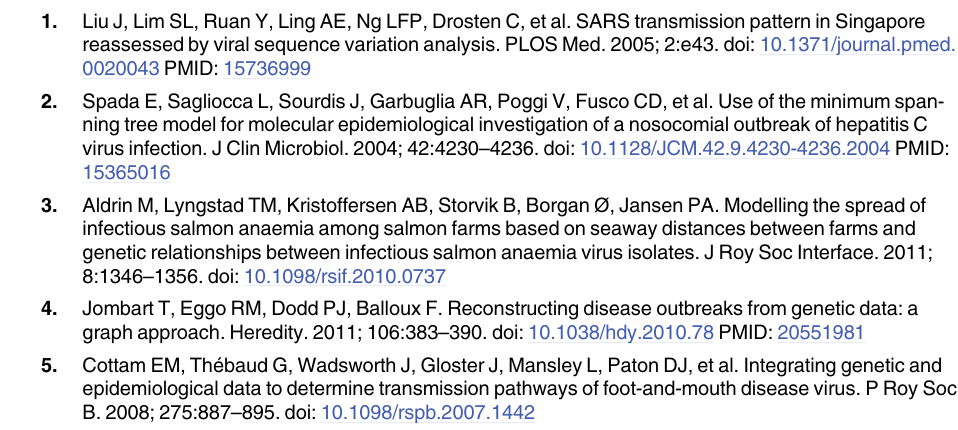
S2 Text. Supplementary methods 2. Derivation of the